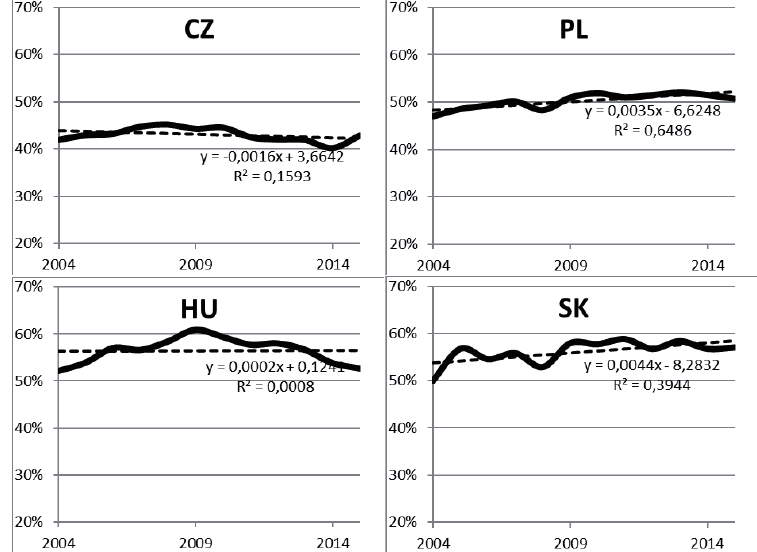
Fig. 2 – Income differences in the V4 countries measured by the coefficient of variation in the period 2004-2015. Source: Own calculations based on Eurostat database (access: